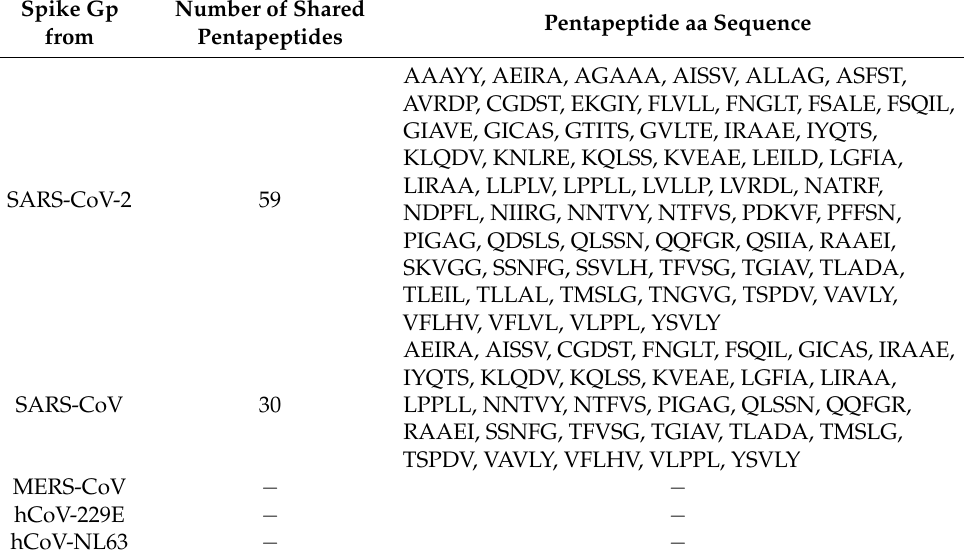
Table 1. Quantitative description of the pentapeptide sharing between CoV spike gps and anti- inflammatory human proteins.